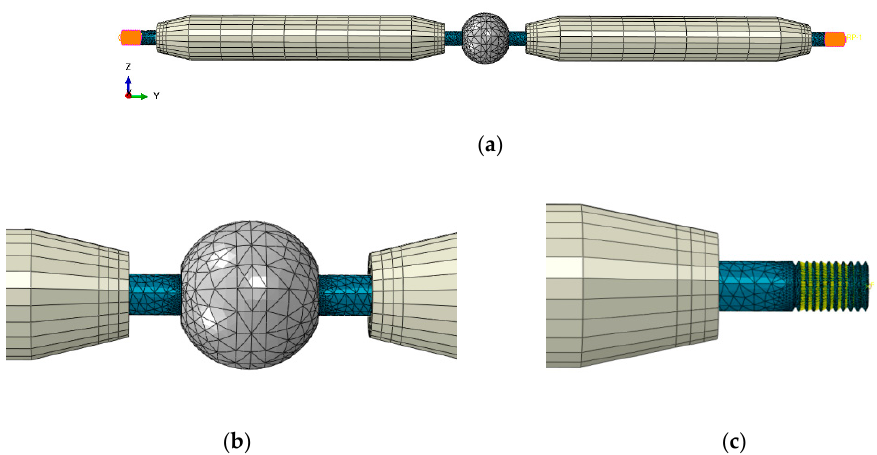
Figure 14. FE model of a typical bolt-sphere joint with members: ( a ) the whole mode; ( b ) the bolt-sphere; ( c ) the cone-head.